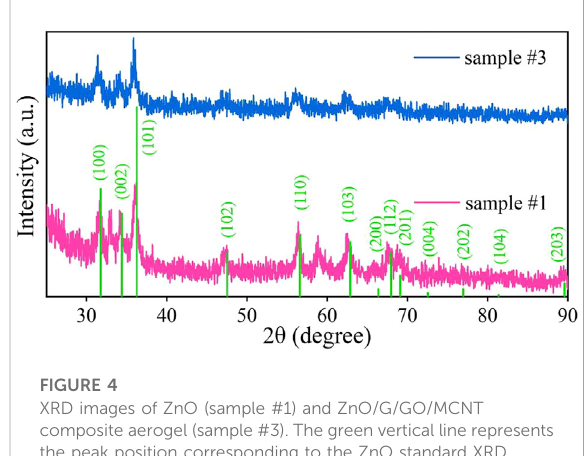
FIGURE 4 XRD images of ZnO (sample #1) and ZnO/G/GO/MCNT composite aerogel (sample #3). The green vertical line represents the peak position corresponding to the ZnO standard XRD standard